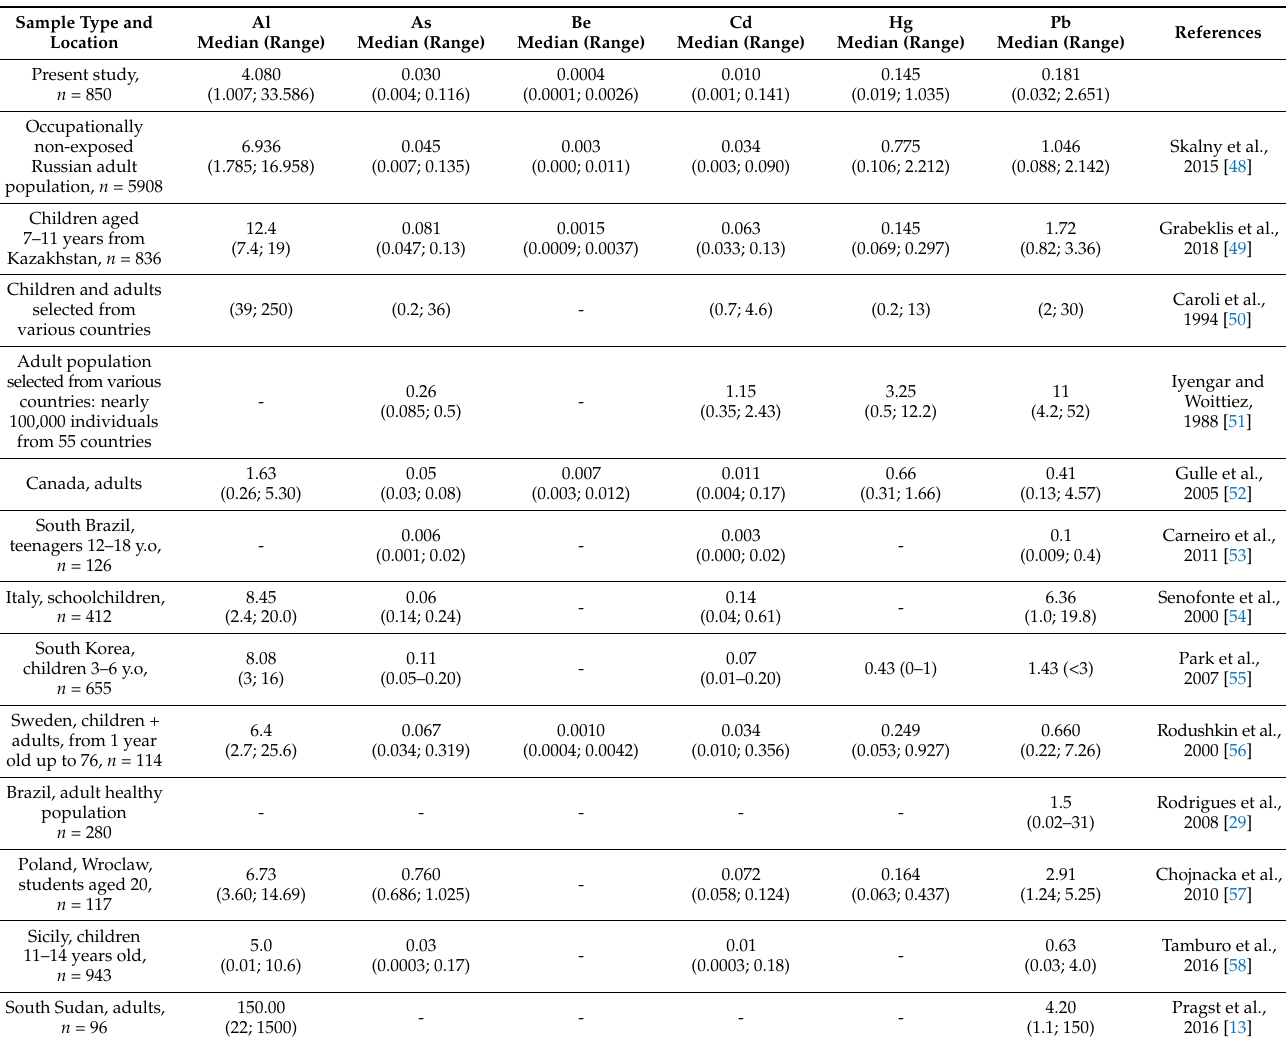
Table 4. Summary of published data on concentrations of toxic trace elements ( µ g/g) in hair in different